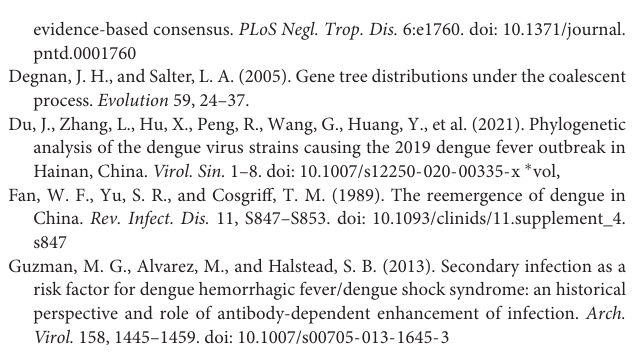
Supplementary Table 1 | Information of 90 dengue viruses in our study. Supplementary Table 2 | The E gene primers and